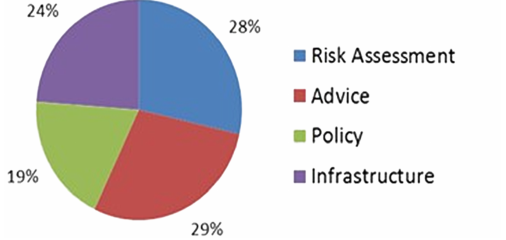
Figure 8. Outcomes of adaptation projects deployed in the Suffolk coastal